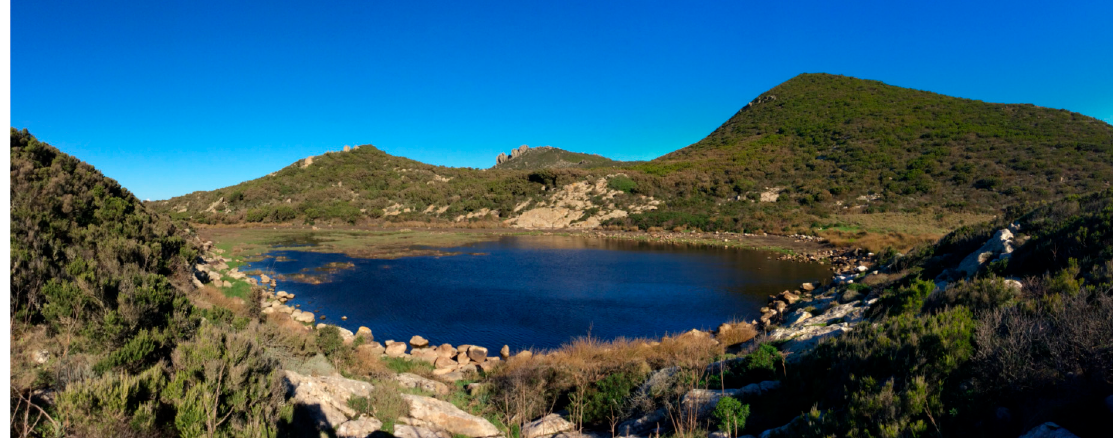
Figure 2. Panoramic view of the Laghetto area.